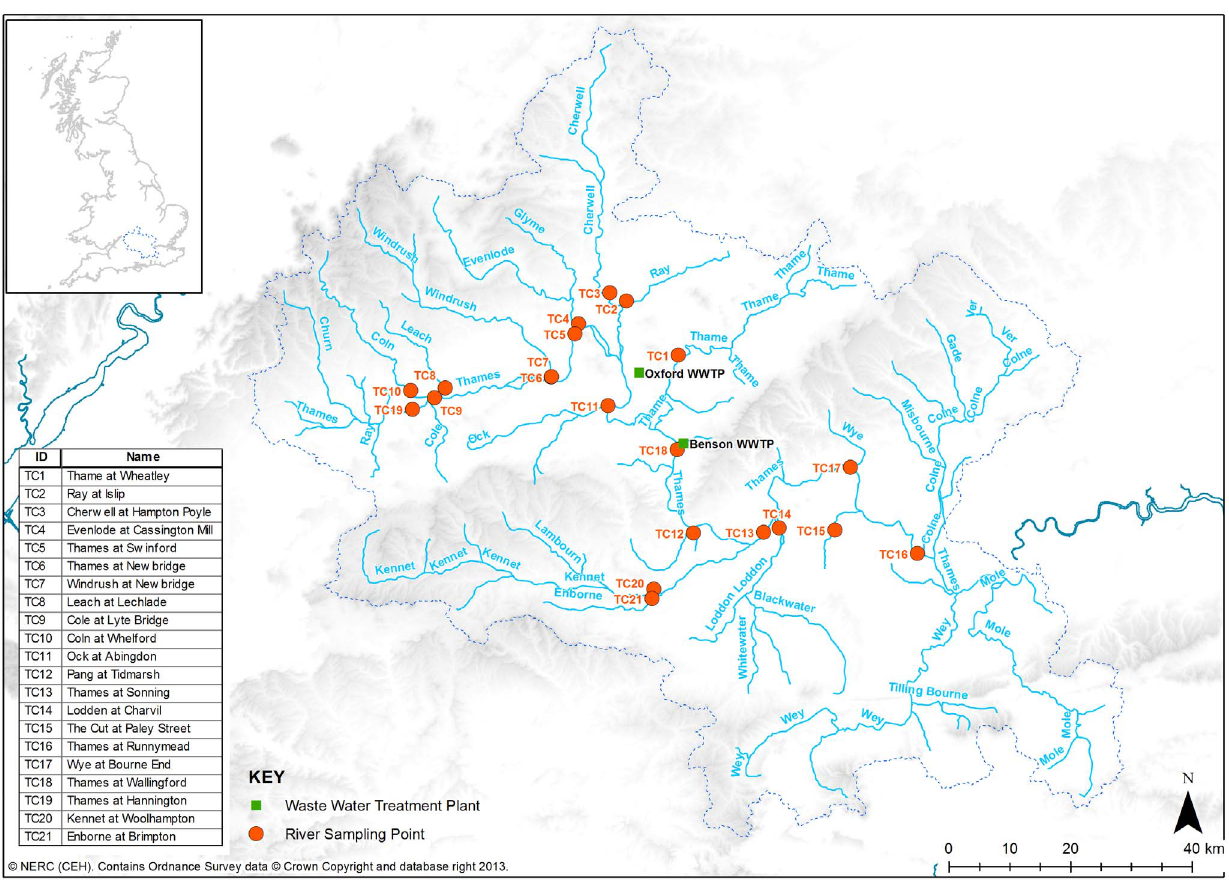
Figure 1. The 21 river sampling locations within the River Thames Catchment (TC) in southern England and the location of the Oxford and Benson WWTPs.